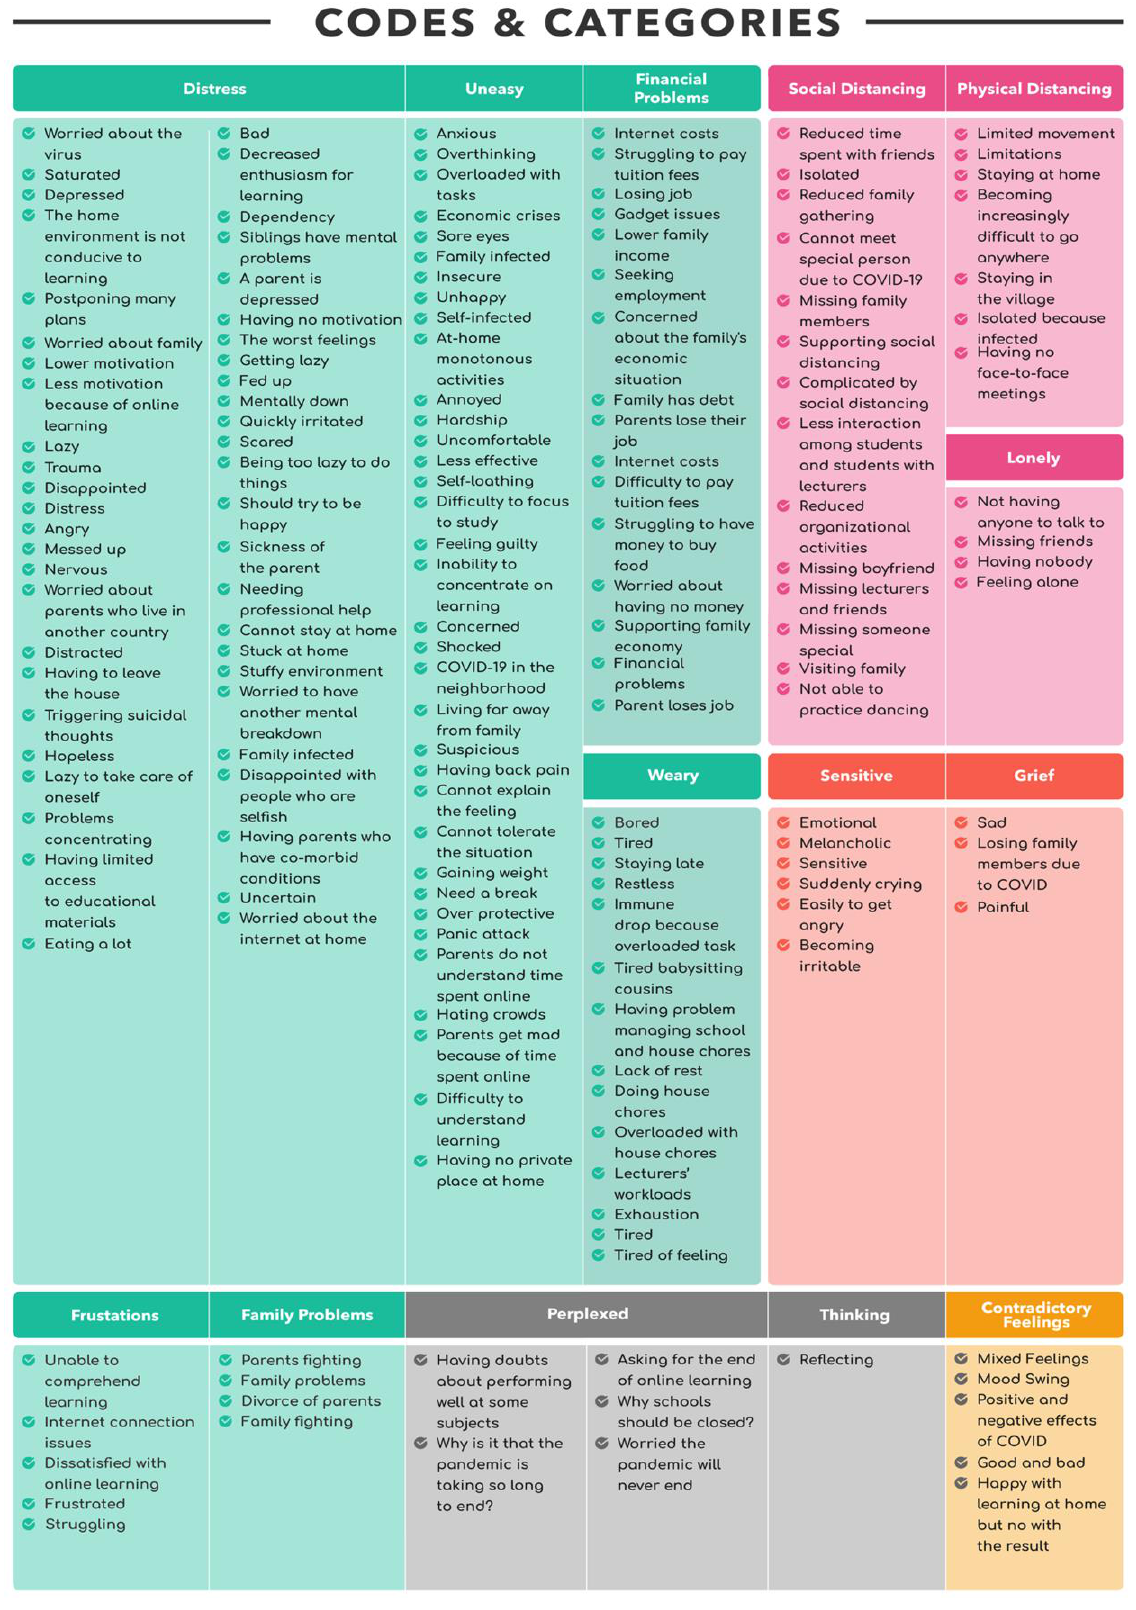
Figure 4. Negative codes and categories.